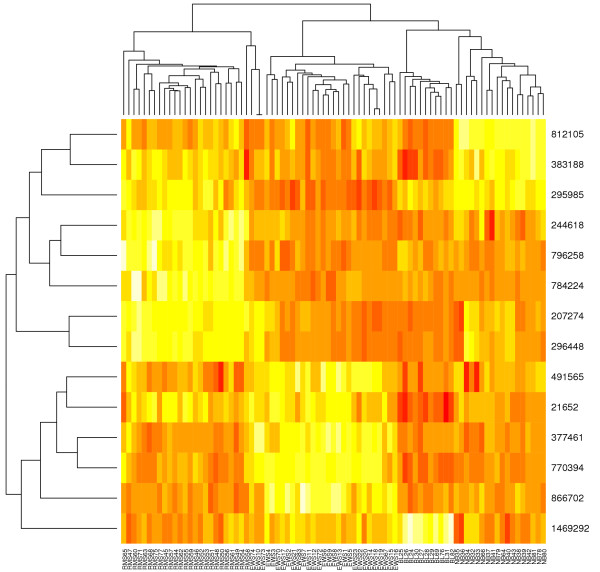
Clustering dendrogram of SRBCT data – Reduced Feature Set.